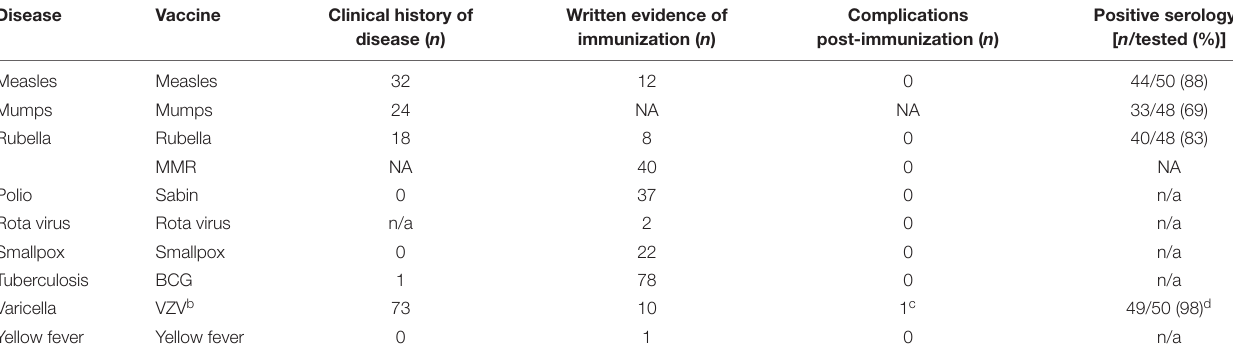
BCG bacillus Calmette–Guérin vaccine, MMR measles, mumps and rubella combined vaccine, n number of patients, n/a not accessed, NA not applicable, VZV varicella zoster virus. a Post-vaccination serology results only were reported in those immunized against varicella. b Patients enrolled in the clinical trial were also included. c Complications are described in detail under the section Clinical trial of live varicella zoster virus vaccine in patients with CHH. d Seronegative patient had no history of varicella or VZV vaccine administration, but deceased before enrollment into VZV vaccine clinical trial.